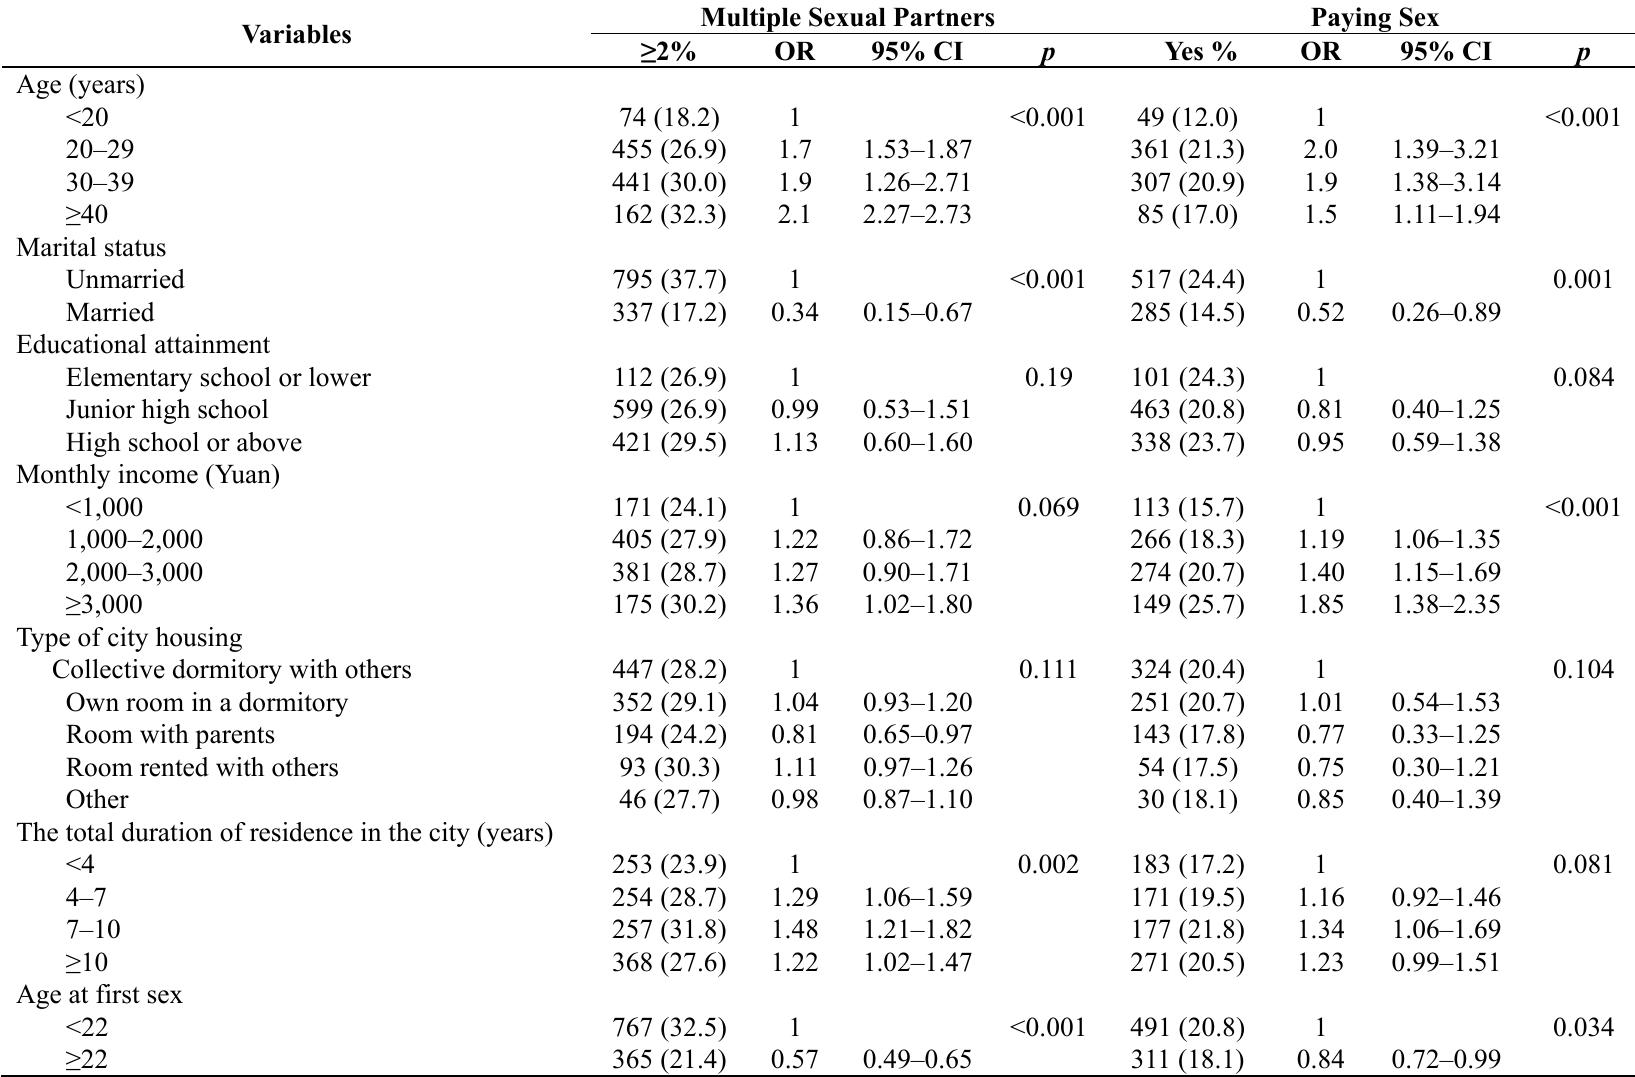
Table 4. Univariate analyses of factors associated with risky sexual